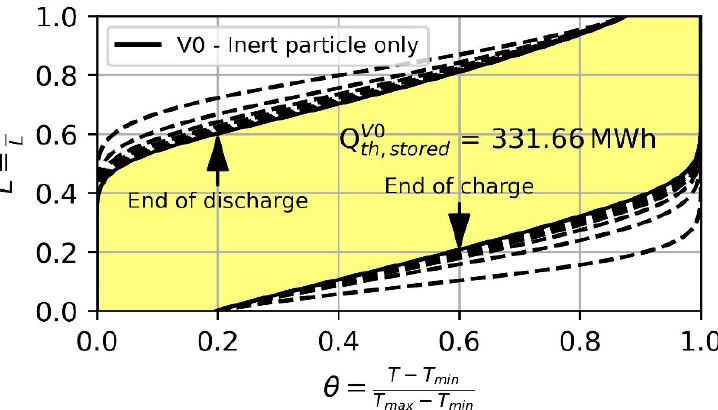
Figure 6. Thermocline in steady state condition at the end of charge and discharge after 15 cycles (solid black line) of the base case (V0) with inert particles only. Dashed lines indicate the thermocline before a steady state is reached.